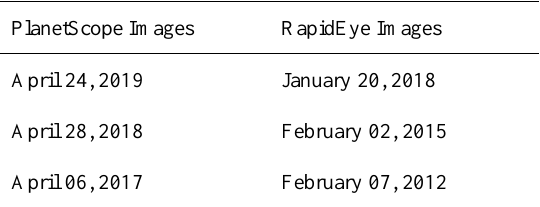
Table 2. Downloaded PlanetScope and RapidEye data used for generating the higher resolution index-based built-up maps